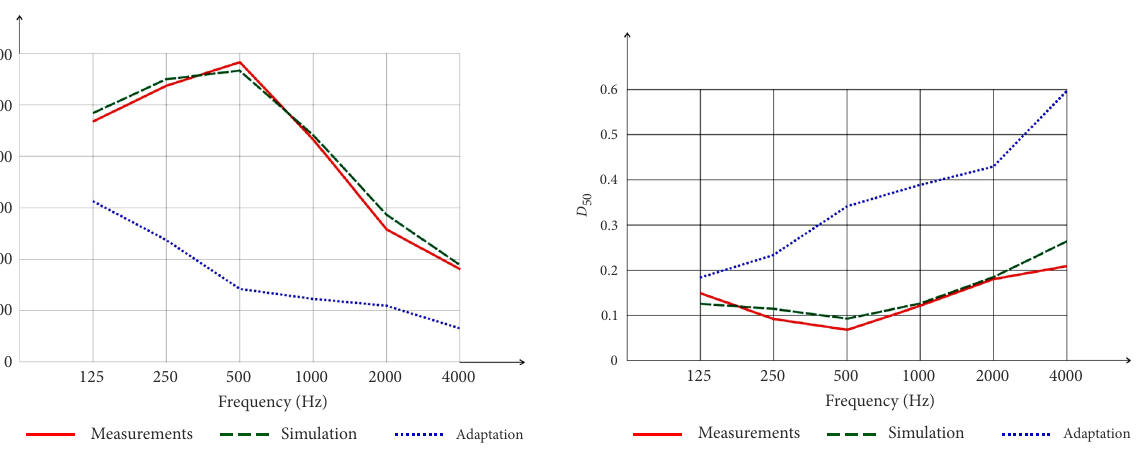
Figure 16. Graph of D 50 in the frequency range – comparison of in situ measurements, simulation and simulation with acoustic treatment